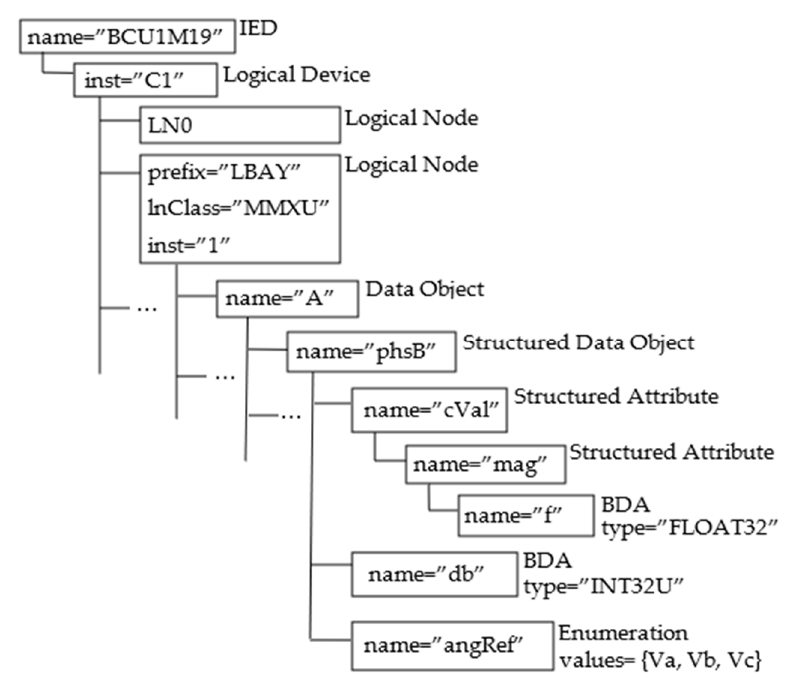
Figure 3. Example of the IEC 61850 data model used throughout the paper.